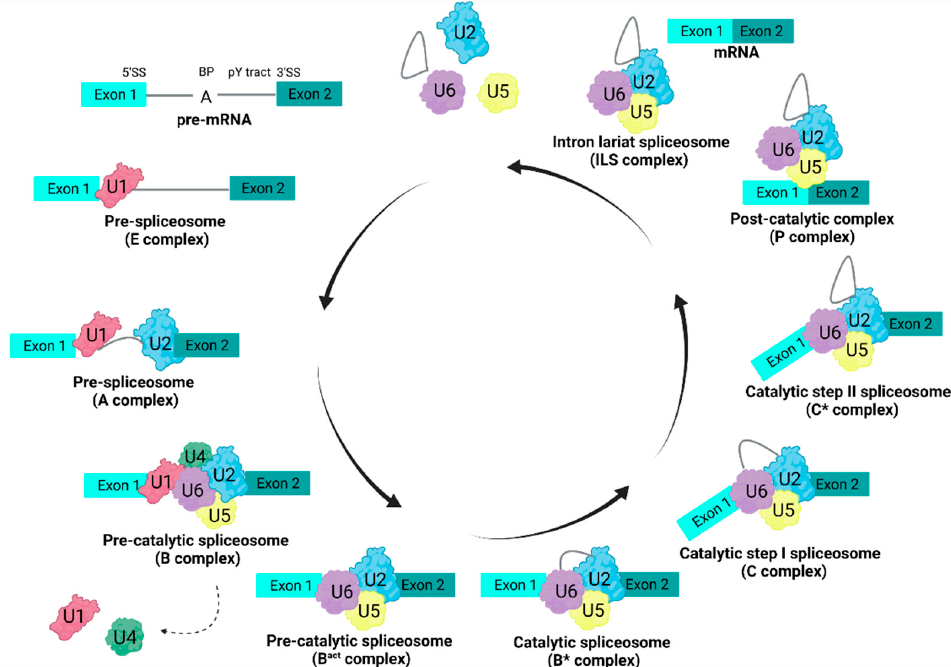
Figure 4. Assembly and the catalytic cycle of the spliceosome. Initially, t he 5 ′ SS, BP and 3 ′ SS are first recognized by the U1 small nuclear ribonucleoprotein (snRNP), forming a pre-spliceosome (E com- plex). The U2 snRNP attaches at exon 2 to subsequently form the A complex, which interacts with the U4, U5, U6 tri-snRNP to assemble into the pre-catalytic spliceosome (B complex). There are at least six additional distinct spliceosome complexes: B act , B*, C, C*, P and the intron lariat spliceosome (ILS complex). Each complex has a unique architecture.